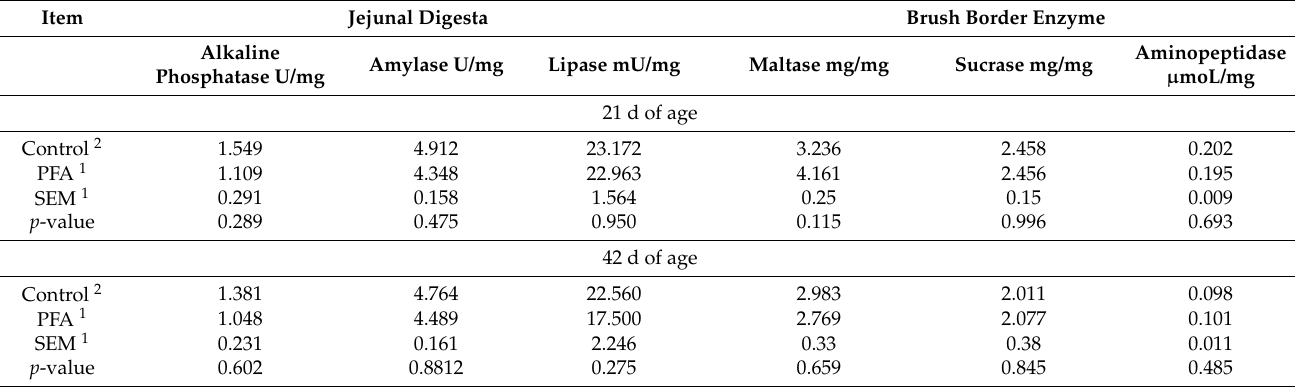
Table 5. Effect of phytogenic feed additive (PFA) on the jejunal digesta and brush border enzyme activities of